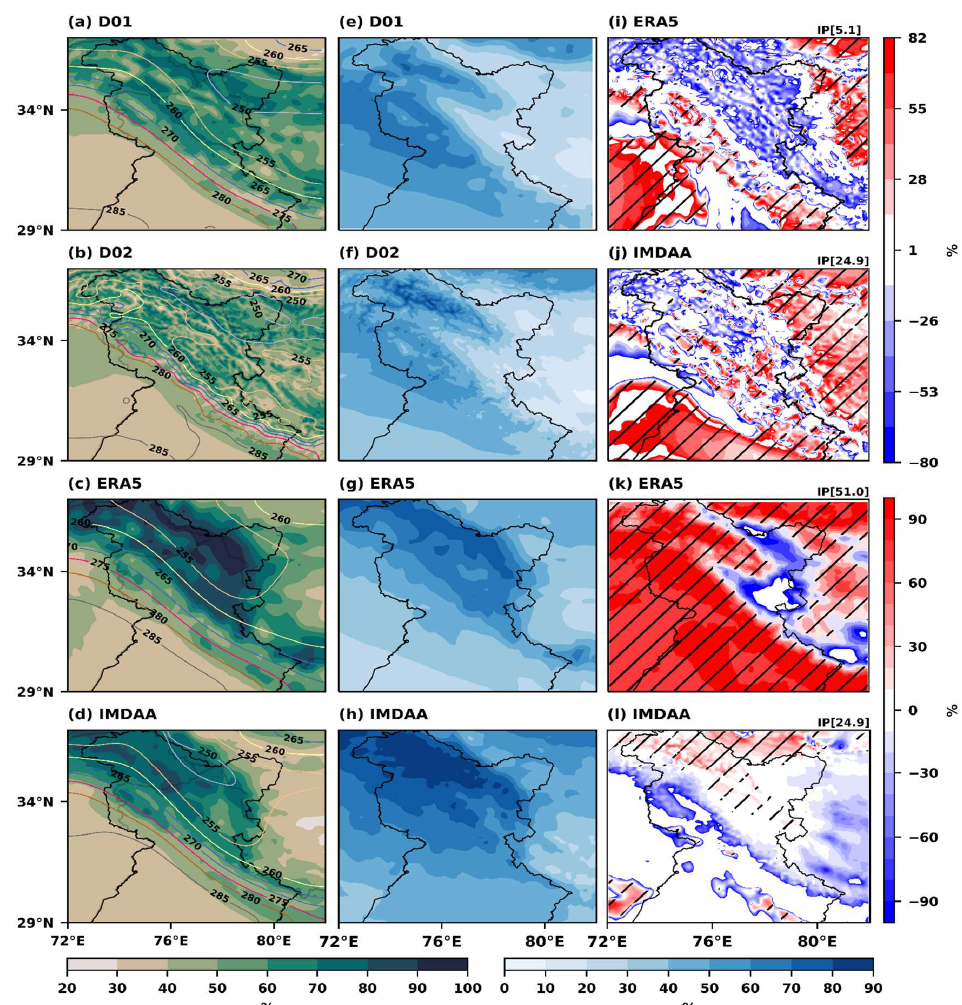
Figure 6. Seasonal average RH and Temperature at 2 m above the ground, observed in model ( a ) D01 and ( b ) D02 and observations ( c ) ERA5 and ( d ) IMDAA. Shading and contours represent the RH and temperature, respectively. Seasonal averaged total cloud cover between the models and ( e ) D01 and ( f ) D02 and the observations ( g ) ERA5 and ( h ) IMDAA. The seasonal forecast impact (IP) parameter for RH and total cloud cover with ERA5 ( i ), IMDAA ( j ), ERA5 ( k ), and IMDAA ( l ), re- spectively.